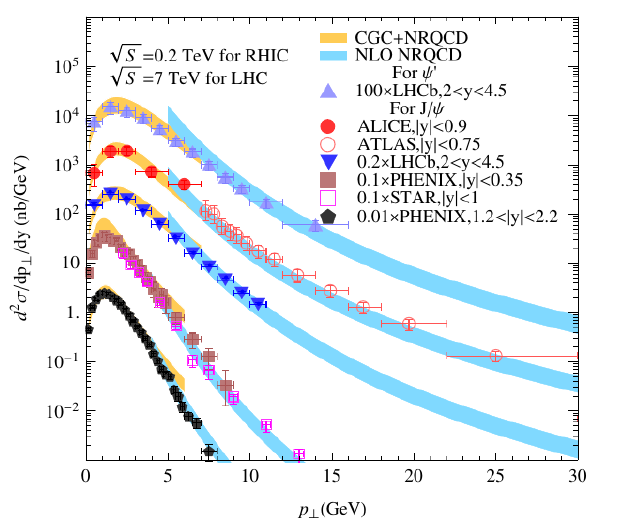
Figure 22. The ψ (cid:48) (top curve) and J / ψ (other four curves) differential cross section as a function of p T . Figure from the work in